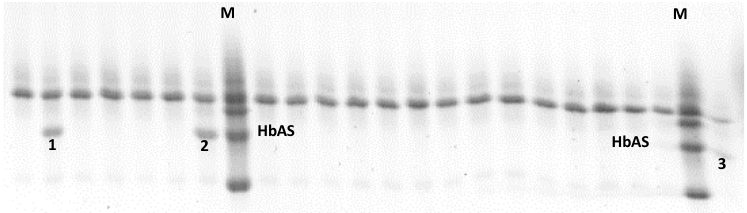
Figure 1. Horizontal hemoglobin electropherogram for the identification of HbAS carriers. Numbered bands show the presence of hemoglobin S (HbAS) for JT (1), HH (2) and MJ (3) donors, respectively. M: Hb marker.